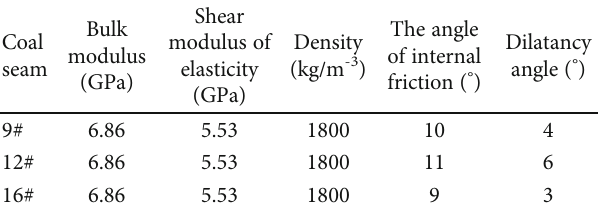
Table 3: Rock mechanics parameters of the coal seam. Coal